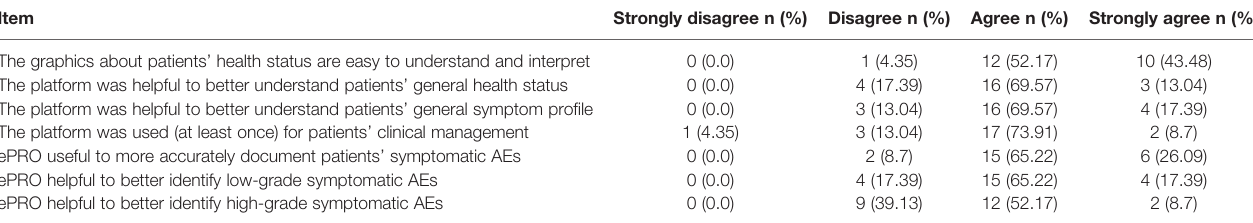
TABLE 2 | Evaluation of patients ’ health status and symptoms pro fi le.